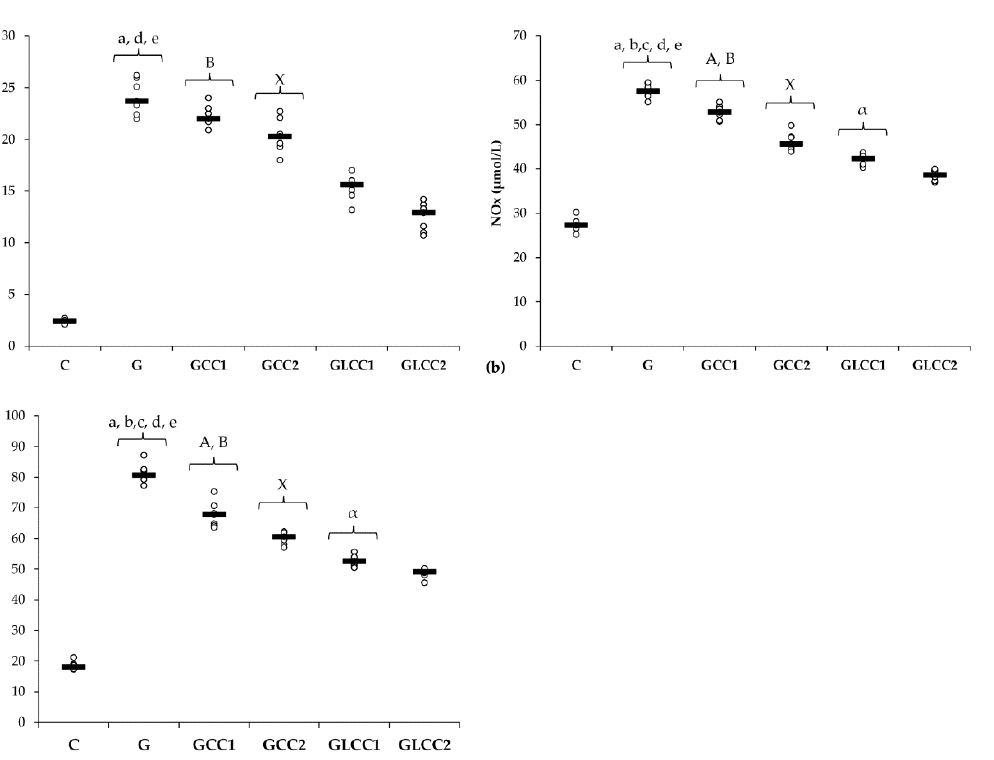
Figure 2. Variation by groups of serum oxidative stress intensity: ( a ) MDA (malondialdehyde), ( b ) NOx (nitric oxide), ( c ) TOS (total oxidative status) by groups. Notes: The circles represent the individual values, and the horizontal line is given by the median. Abbreviations: C, Control; G, Gentamicin; GCC1, Gentamicin and CC1 solution; GCC2, Gentamicin and CC2 solution; GLCC1, Gentamicin and LCC1 solution; GLCC2, Gentamicin and LCC2 solution; The letter codes corre- spond to the p -values < 0.006: a G compared to C; b G compared to GCC1; c G compared to GCC2; d G compared to GLCC1; e G compared to GLCC2; A GCC1 compared to GCC2; B GCC1 compared to GLCC1; X GCC2 compared to GLCC2; α GLCC1 compared to GLCC2. Table 2. Serum levels of antioxidant capacity.